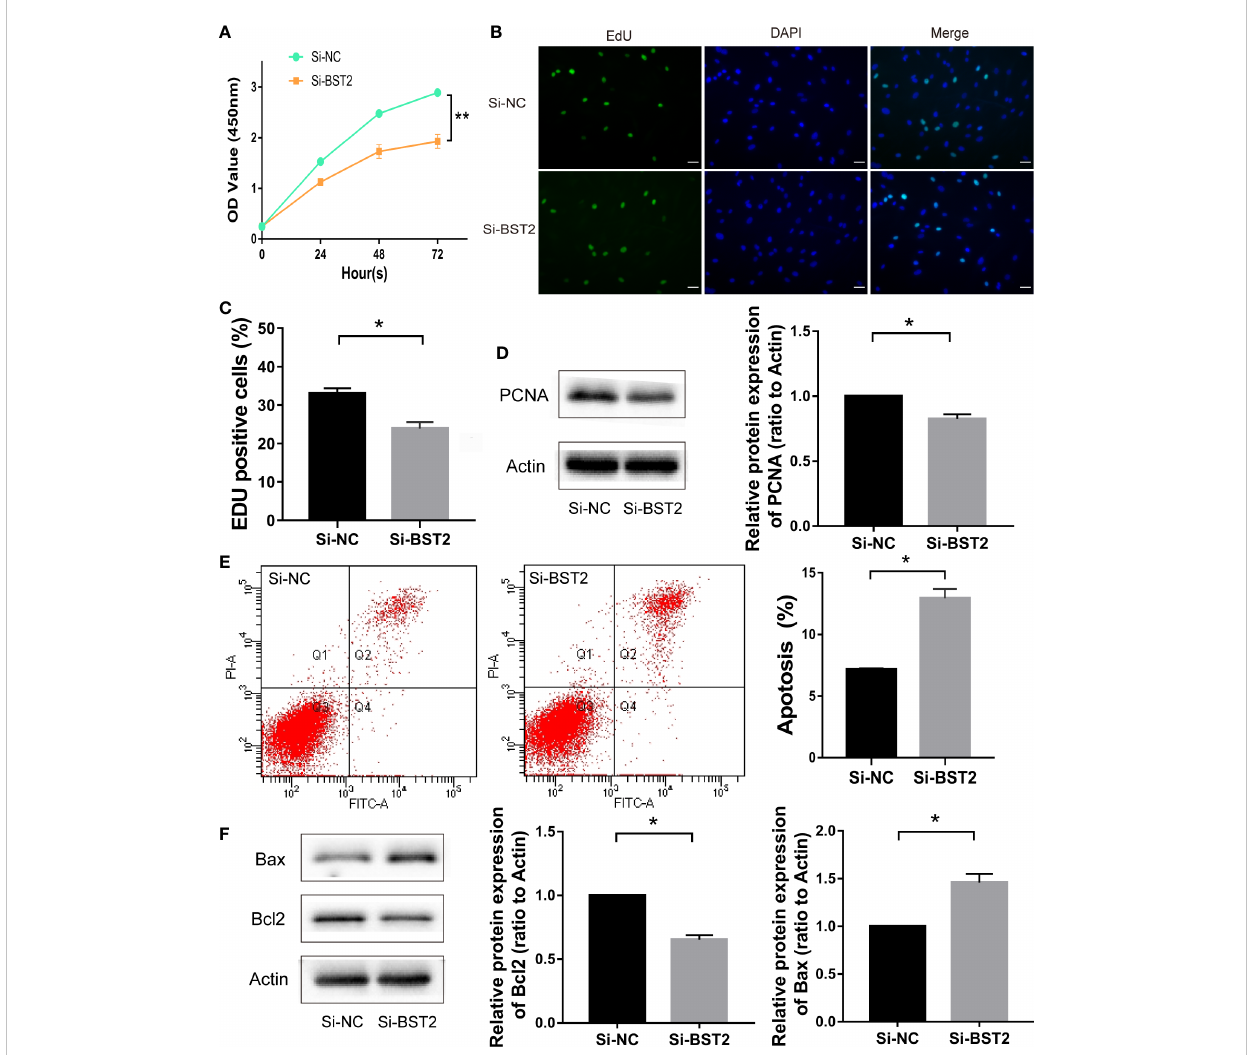
FIGURE 3 The effect of BST2 on cell proliferation and apoptosis. (A – C) , The proliferation of EESCs was examined by CCK-8 assay (A) and EdU (B, C) after Si- BST2 or Si-NC treatment for 48 h. (D) , The proliferation-related protein PCNA was measured by Western blot assay after Si-BST2 or Si-NC treatment for 48 h. (E) , The Flow cytometry was performed to detect the apoptosis rates of the EESCs transfected with Si-BST2 or Si-NC. (F) , Western blot analysis was used to measure the levels of Bax and Bcl2 in cells transfected with Si-BST2 or Si-NC. *p < 0.05; **p <